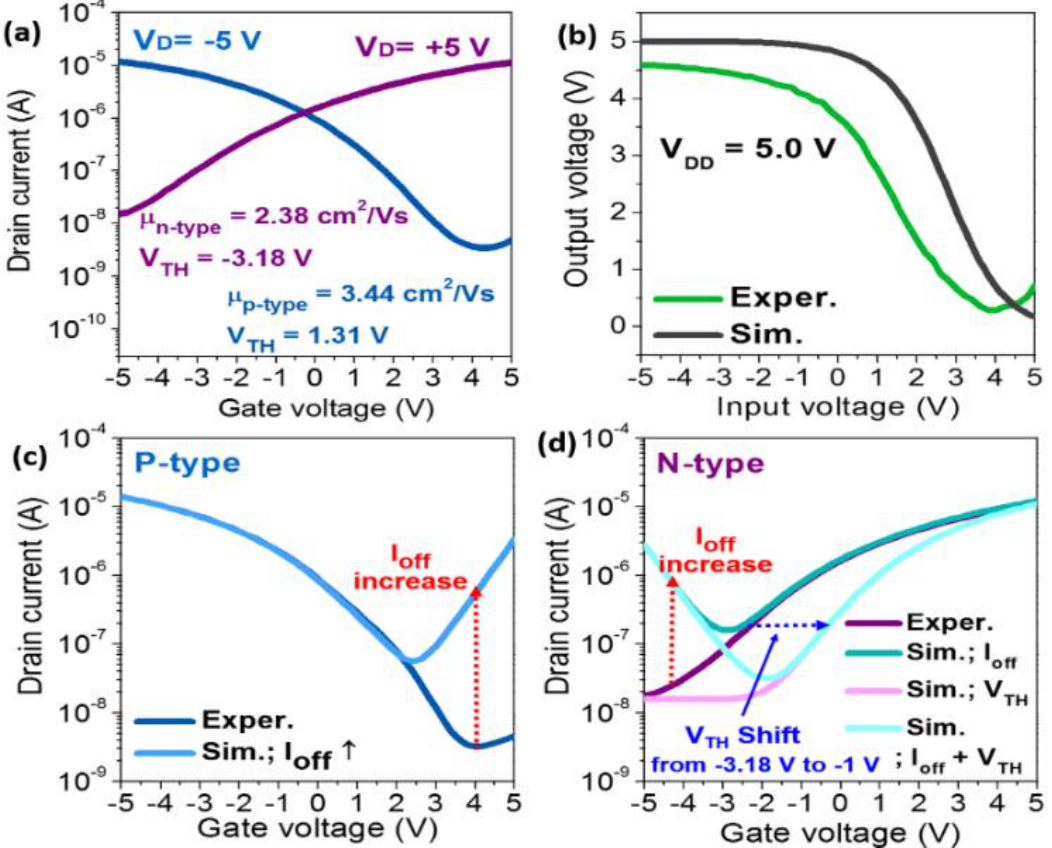
Figure 2. ( a ) Transfer curves of p-type and n-type of fiber-based SWCNTs transistors; ( b ) the experimental (Exper.) and the simulated (Sim.) voltage transfer curves of the fiber-based CMOS inverter circuits; and ( c ) the p-type and ( d ) n-type fiber-based SWCNT transistors when applying several variable